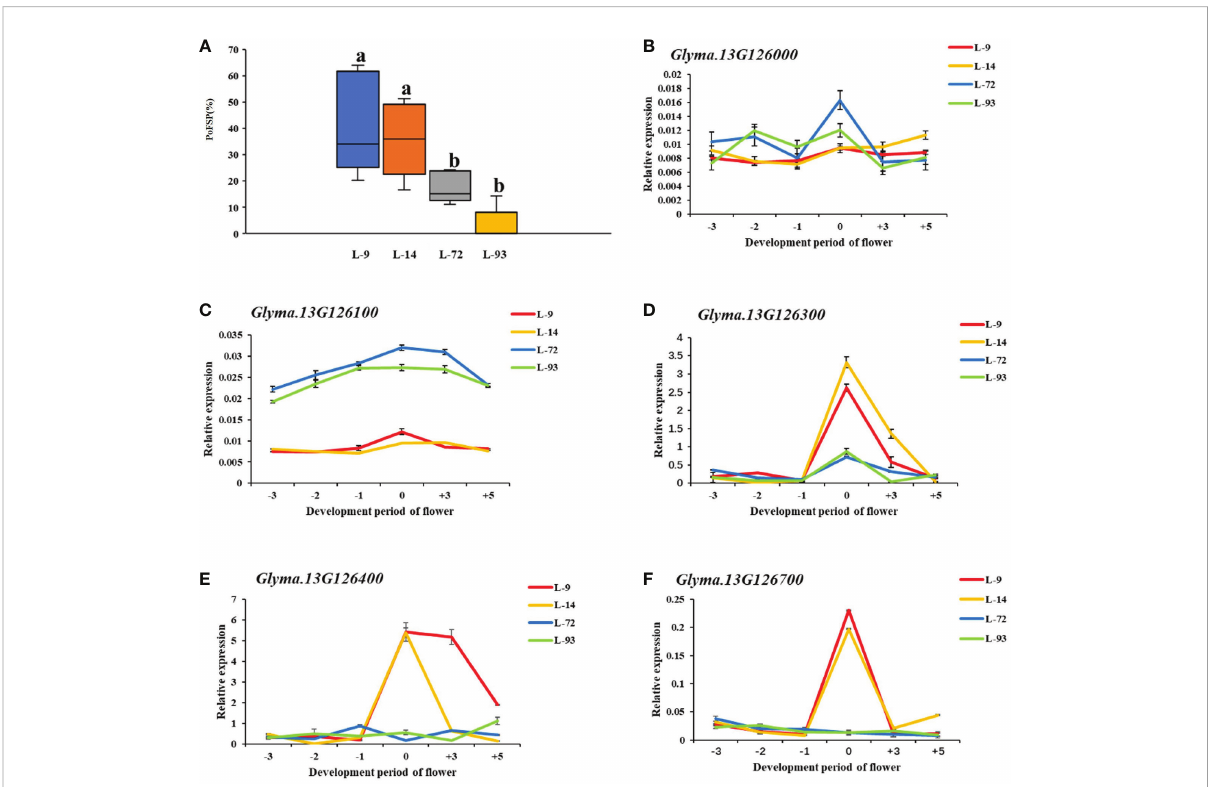
FIGURE 7 Expression analysis of candidate genes. (A) : Phenotypic identi fi cation of extreme materials. (B – F) : Real-time PCR results of the candidate genes. a : Different letters indicate the signi fi cant differences at the 0.05 level, while the same letters indicate the nonsigni fi cant differences. b-f : -3, -2, -1, 0, + 3, +5 represent 3 days before fl owering, 2 days before fl owering, 1 day before fl owering, the day of fl owering, 3 days after fl owering, 5 days after fl owering,